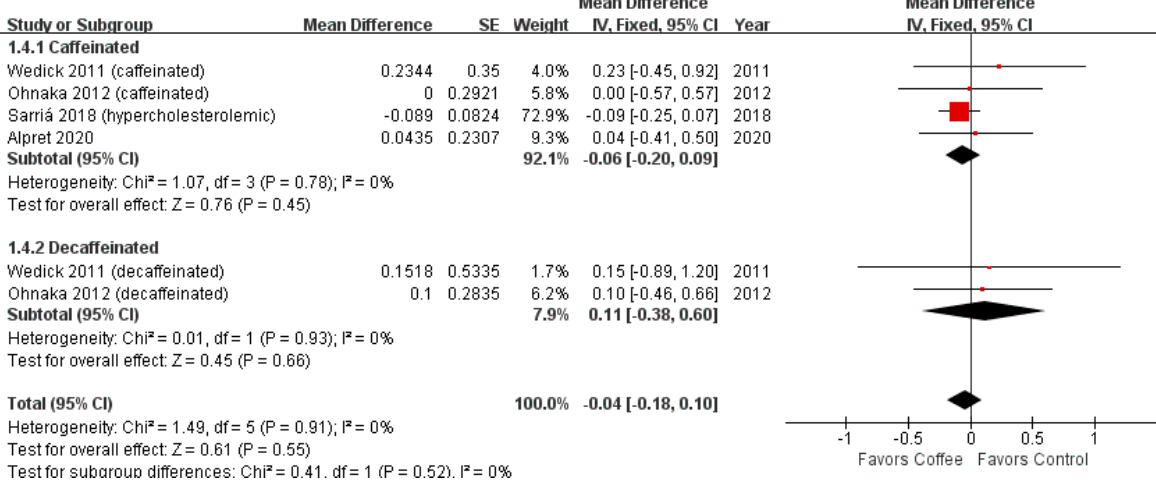
Figure 4. Effects of coffee on HOMA-IR (Sensitivity analysis).